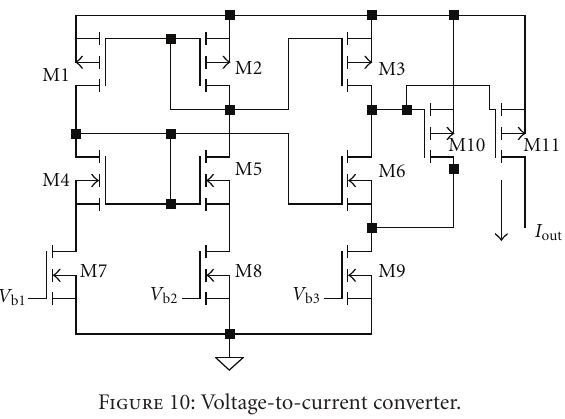
Figure 10: Voltage-to-current converter.